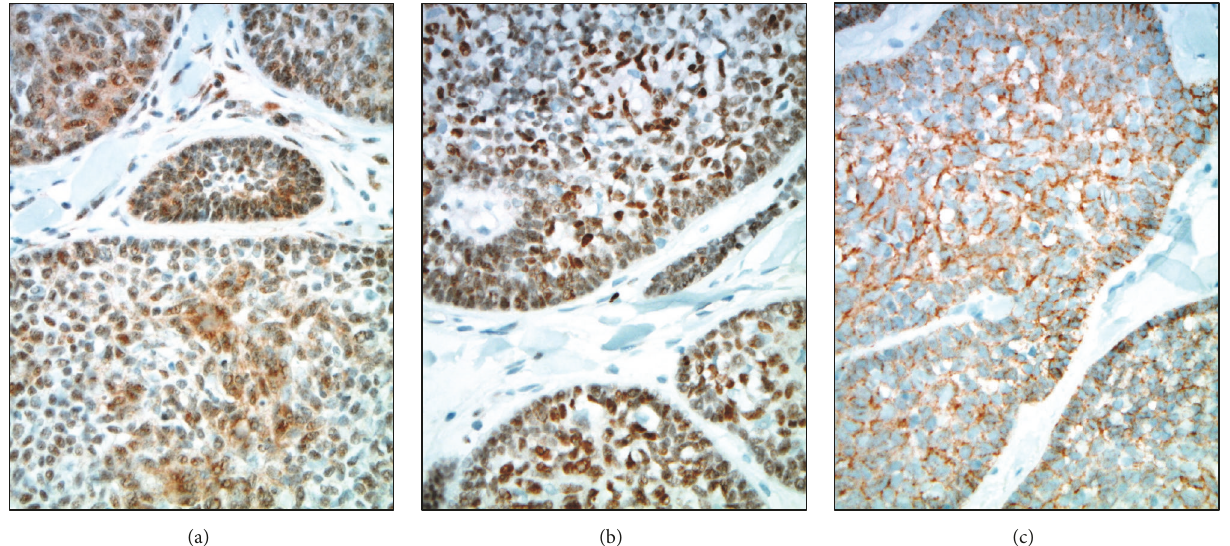
Figure 5: High magnification immunohistochemistry of selected breast tumor markers: (a) diffuse nuclear and cytoplasmic positivity of moderate intensity, mammaglobin, 400x; (b) diffuse and strong nuclear and focal cytoplasmic positivity throughout tumor cell groups, GATA3, 400x; (c) diffuse and moderately intense cytoplasmic positivity throughout tumor cell groups, E-cadherin, 400x.